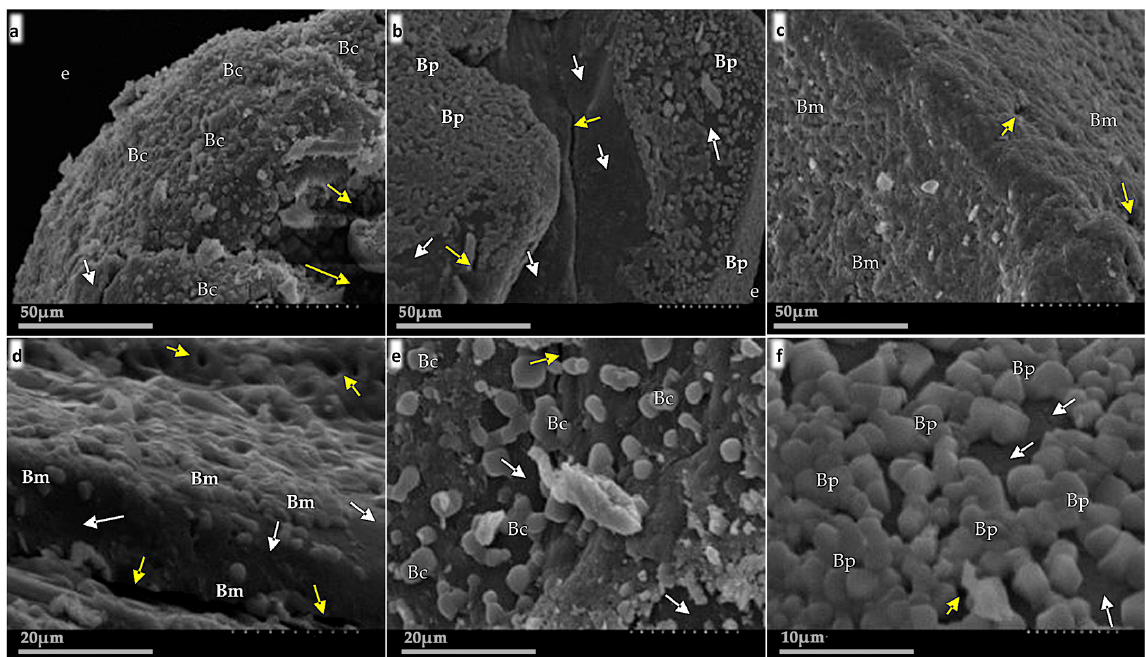
Figure 2. Scanning electron microscopy (SEM) of the surface of microbeads, where white arrows indicate the surface of the microbead, and yellow arrows indicate pores. ( a ) Bacillus cabrialesii TE3 T (Bc) microbead rim. ( b ) Microbead containing B. paralicheniformis TRQ65 (Bp) , showing the space and structure of the internal cavity (typical of alginate microbeads) without bacteria, and the sides loaded with bacteria. ( c ) Shows the surface of a microbead containing B. megaterium TRQ8 ( Bm) . ( d ) Magnification and side view of a microbead containing B. megaterium TRQ8, showing more clearly a load of this strain and its distribution in the microbead. ( e ) Magnification of subfigure ( a ) showing the population of B. cabrialesii on the microbead. ( f ) Close-up of the subfigure ( b ) showing the microbead surface colonized by B. paralicheniformis .